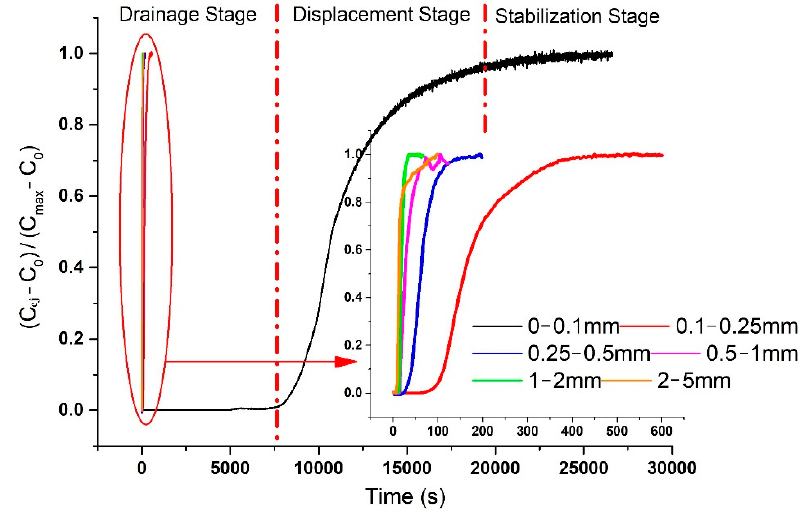
Figure 7. One-dimensional dispersion curves of single-grained coral sands .